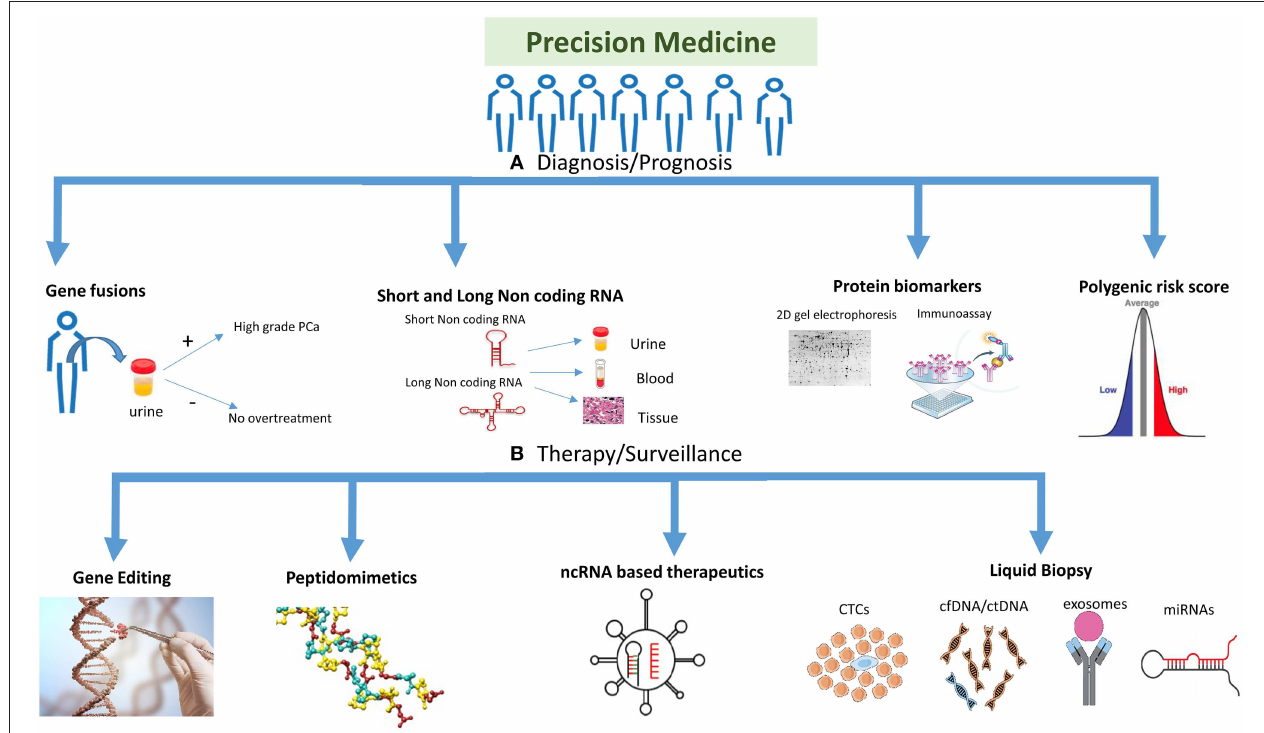
FIGURE 1 | Highlighting the different strategies used for precision medicine. The precision medicine approach could be divided into different strategies and technologies which are being used to target the disease. (A) Diagnosis/prognosis: polygenic risk profiling could help differentiate a population or individual into high/intermediate/low risk patient, whereas molecular markers like gene fusions, protein biomarkers (e.g., 2D gel electrophoresis, MS-based proteomics and immunoassays) and non-coding RNA (short and long) could help detect prostate cancer (PCa) at different stages of the disease including primary tumor stage or treatment response. Gene fusions could help in detecting PCa at different stages and also in reducing overtreatment for patients. (B) Therapy/surveillance: clinical utility of circulating tumor cells (CTCs), circulating tumor DNA (ctDNA), and cell free DNA (cfDNA), microRNAs (miRNAs), and exosomes represents an evolution in cancer diagnosis, prognosis, and treatment. New viral/nanoparticle-based non-coding RNA (ncRNA) therapeutics have evolved in the twenty-first century with many siRNA and miRNA-based therapies in clinical trials. Antisense oligonucleotides and peptidomimetics offer an out-of-the-box approach to target genes and proteins at transcriptional and translational levels repressing their activities. Gene editing is a fascinating approach being improved on a daily basis, which could target the disease at DNA level to repair mutations or inhibiting fusion genes. Gene editing image credit: Getty images